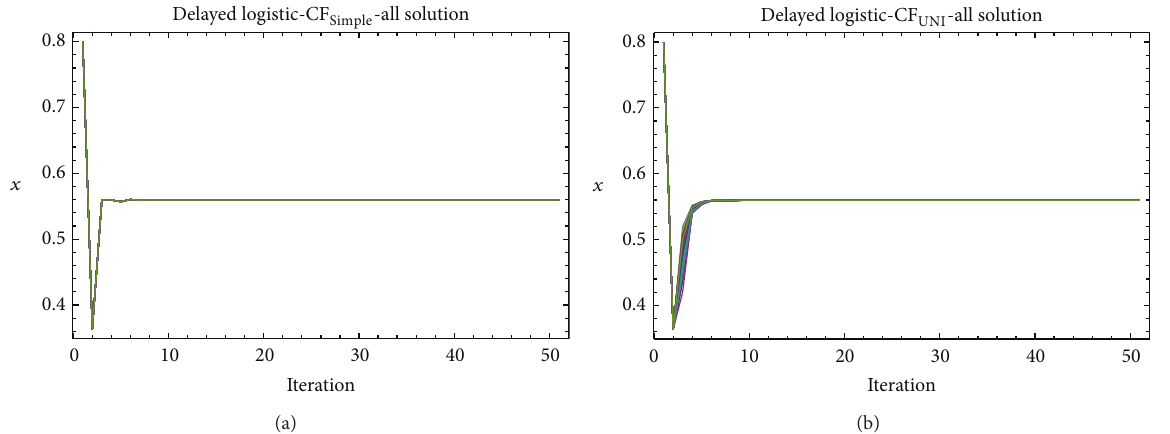
Figure 14: Simulation of all the 50 independent runs of EA, ChaosDE and Delayed logistic: case study 3, CF Simple (a); case study 4, CF